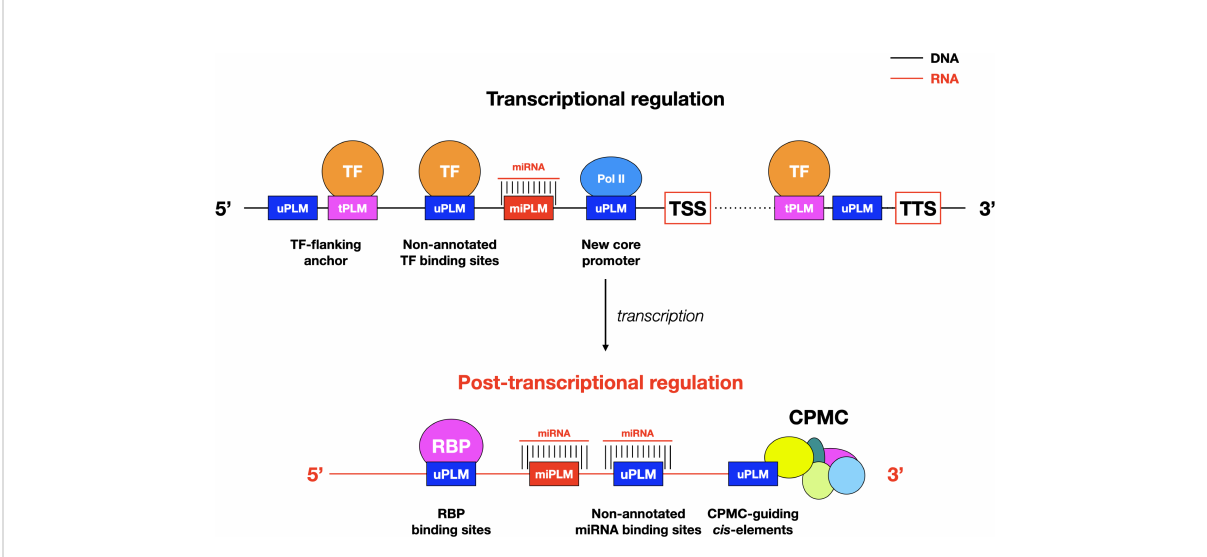
FIGURE 8 Models of PLM-mediated transcriptional and post-translational controls in plants. The models integrate only the results presented here. Possible interactions between the illustrated components and the diverse array of other intermediates such as enhancers and long-distance chromatin interaction sites, remain to be investigated. CPMC, cleavage and polyadenylation molecular complex; Pol II, RNA polymerase II; RPB: RNA binding